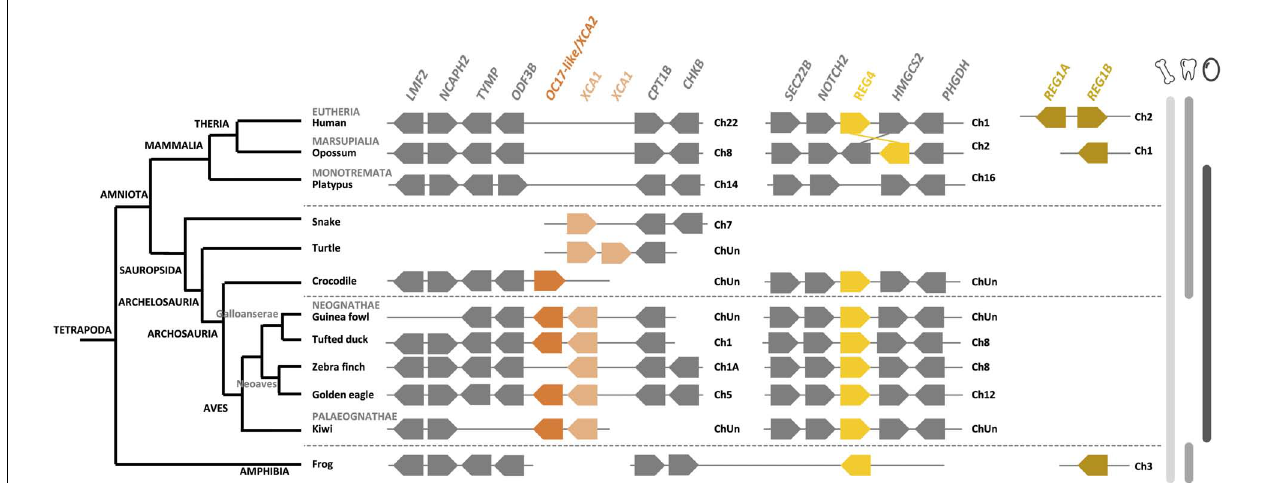
FIGURE 9 | Synteny of OC17-like , XCA and REG orthologs and paralogs in birds and its relatives in vertebrates. OC17-like/XCA2 is represented by a dark orange box and XCA1 by a light orange box. REG4 (regenerating Islet-derived protein 4) is represented by a yellow box and REG1 A and B (Lithostathine) are represented by a brown box. Flanking genes are represented by gray boxes: lipase maturation factor 2 ( LMF2 ), condensing-2 complex subunit H2 ( NCAPH2 ), thymidine phosphorylase ( TYMP ), outer dense fiber protein 3B ( ODF3B ), carnitine O -palmitoyltransferase 1 ( CPT1B ), choline/ethanolamine kinase ( CHKB ), vesicle-trafficking protein ( SCE22B ), neurogenic locus notch homolog protein 2 ( NOTCH2 ), hydroxymethylglutaryl-CoA synthase ( HMGCS2 ) and D-3-phosphoglycerate dehydrogenase ( PHGDH ). Gene IDs are listed in Supplementary Table 2 . The left part of the figure depicts the phylogenetic relationship between vertebrate species (adapted from www.tolweb.org and Kapusta et al.,